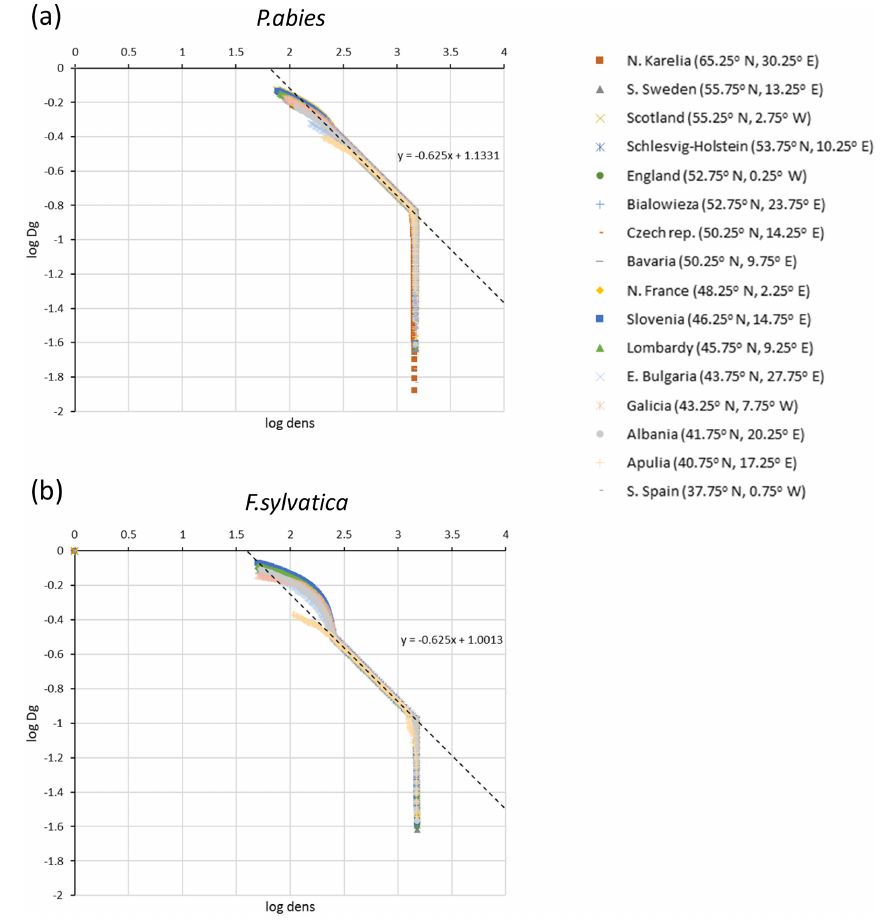
Figure C1. Self-thinning log–log plots of quadratic mean diameter (Dg) and tree density (dens) for simulations of (a) Picea abies and (b) Fagus sylvatica monocultures at 16 European sites used for automated thinning in the